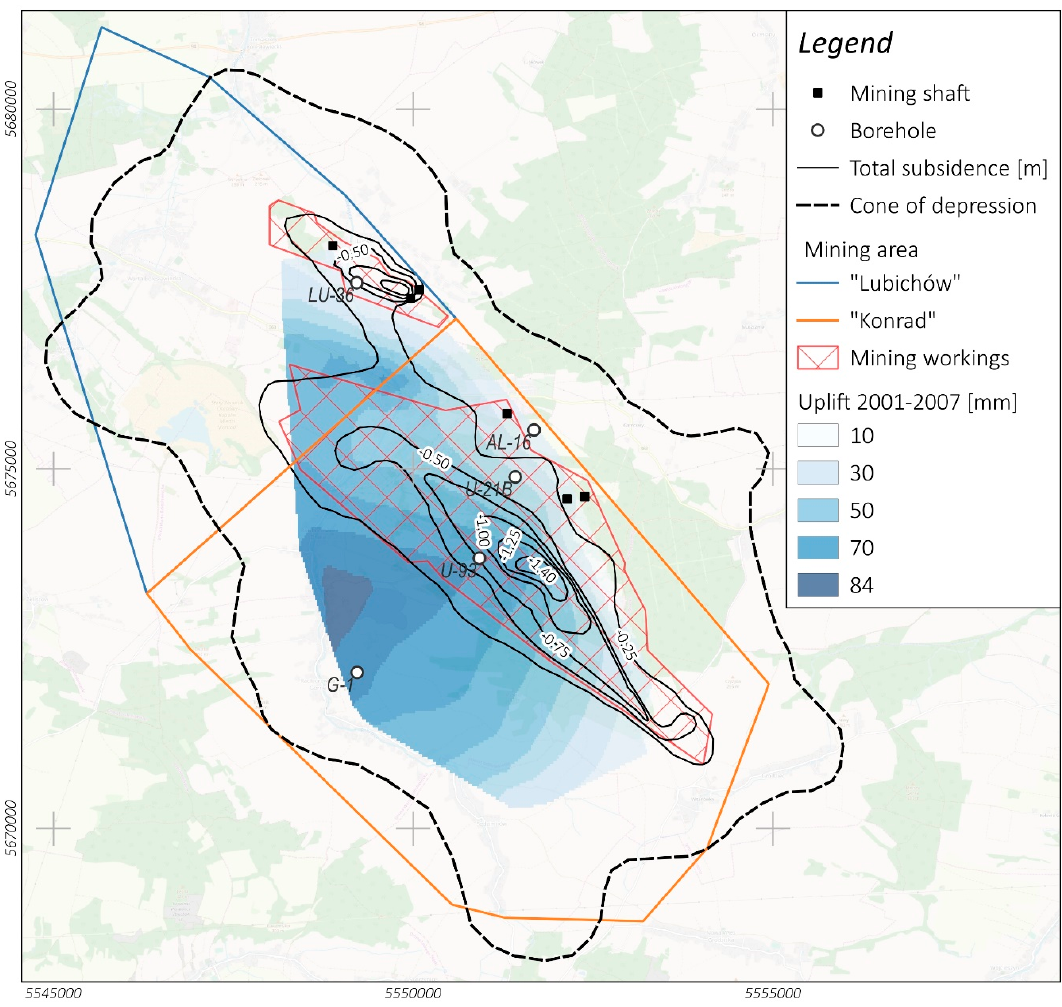
Figure 2. Impact of mining exploitation on the surface area, total land subsidence, and land uplift observed from 2001 to 2007; modified after [37].